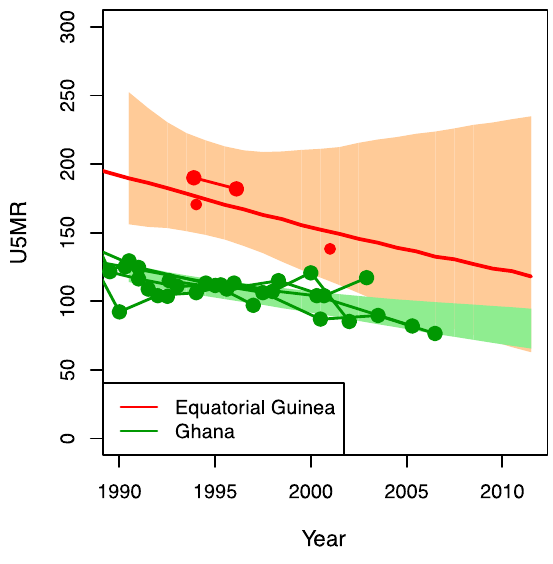
Figure 5. U5MR from 1990 to 2011 for Ghana and Equatorial Guinea. Point estimates (lines), UIs (shaded areas), and data series (connected dots) for Ghana (green) and Equatorial Guinea (red).